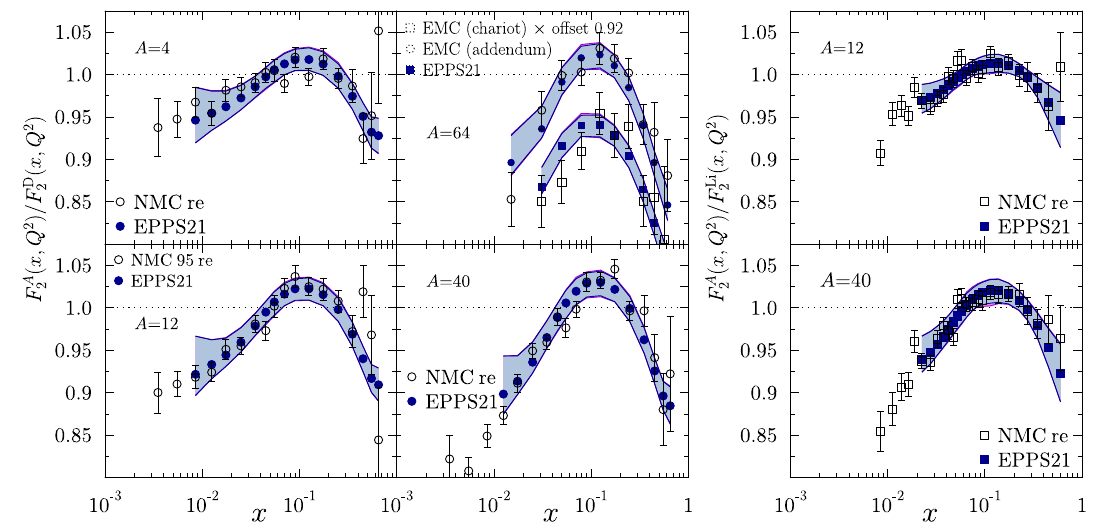
Fig. 19 Structure–function ratios from the NMC [44,45] and EMC [48] experiments compared with the EPPS21 analysis. The solid blue points show our central results, inner blue bands the nuclear uncertainties, and the purple bands the total uncertainty